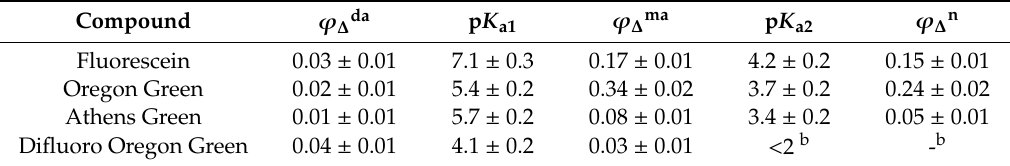
Table 4. Relative O 2 (a 1 ∆ g ) quantum yields, ϕ ∆ , in air-saturated D 2 O for the neutral (n), monoanionic (ma), and dianionic (da) species, and the corresponding p K a values for the interconversion between them, as obtained through Equation (1). a. Compound ϕ ∆ da p K a1 ϕ ∆ ma p K a2 ϕ ∆ n Fluorescein 0.03 ± 0.01 7.1 ± 0.3 0.17 ± 0.01 0.15 ± 0.01 Oregon Green 0.02 ±